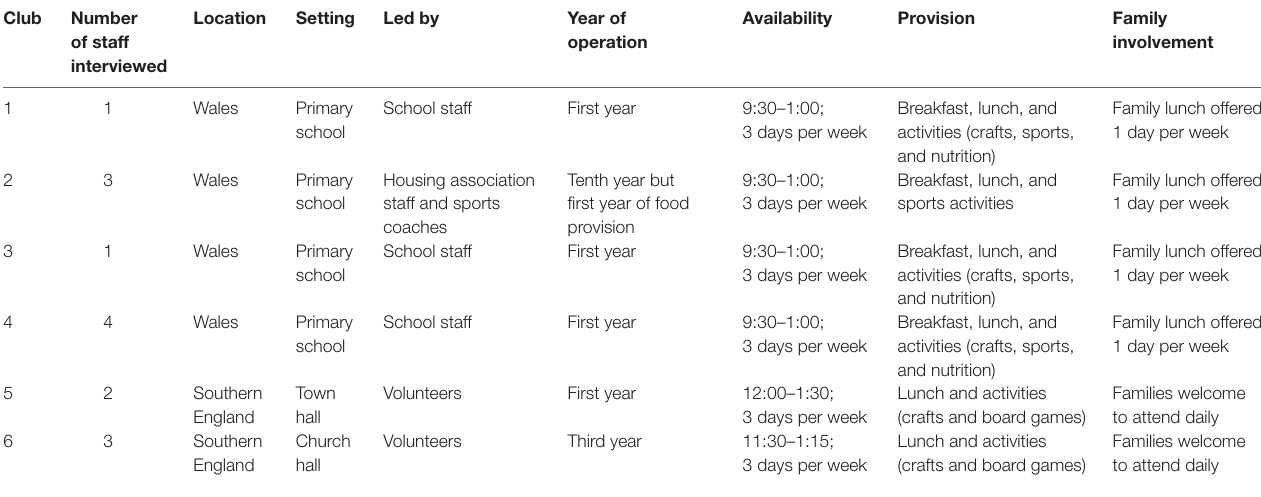
TaBle 1 | characteristics of participating holiday